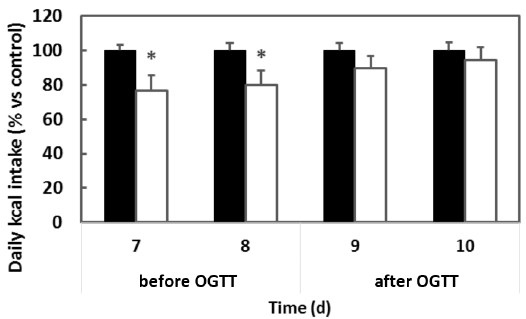
Figure 1. Effect of stressing treatment on food intake measurement. Wistar rats received grape seed proanthocyanidins (GSPE) treatment (0.5 g/kg body weight (BW)) ( white columns) on the days shown